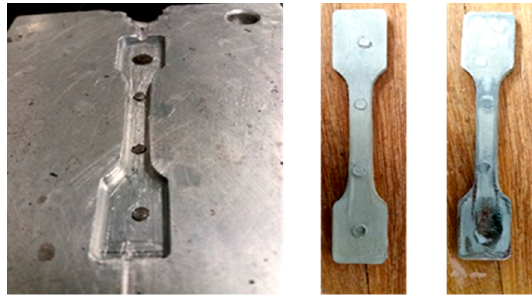
Figure 8. Aluminum mold with green and sintered MIM parts.